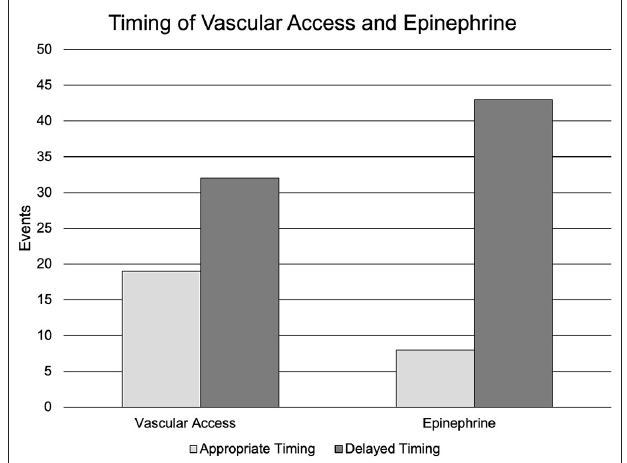
FIGURE 1 | Timing of vascular access and epinephrine. Nineteen (37.2%) events had appropriate vascular access. Thirty-two (62.7%) events had a delay in vascular access. Eight (15.7%) events had appropriately timed epinephrine administration. Forty-three (84.3%) events had a delay in epinephrine administration.